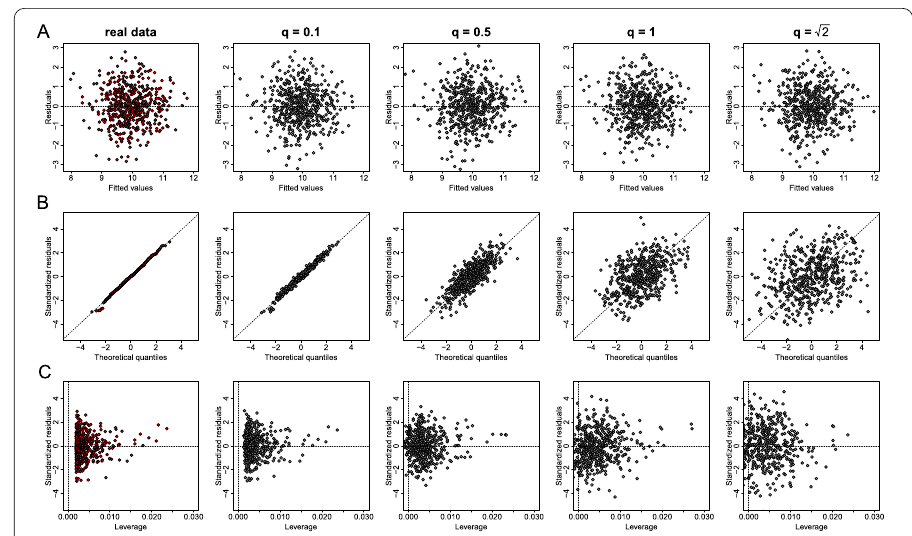
Figure 15 The effect of parameter q of the probabilistic anonymization method on regression plot diagnostics. From left to right we demonstrate the effect of q for the values of 0 (this is equivalent to the real √ 2 on generating privacy-preserving residuals vs fitted values plots ( A ), normal QQ plots data), 0.1, 0.5, 1 and ( B ), and standardized residuals vs leverage ( C